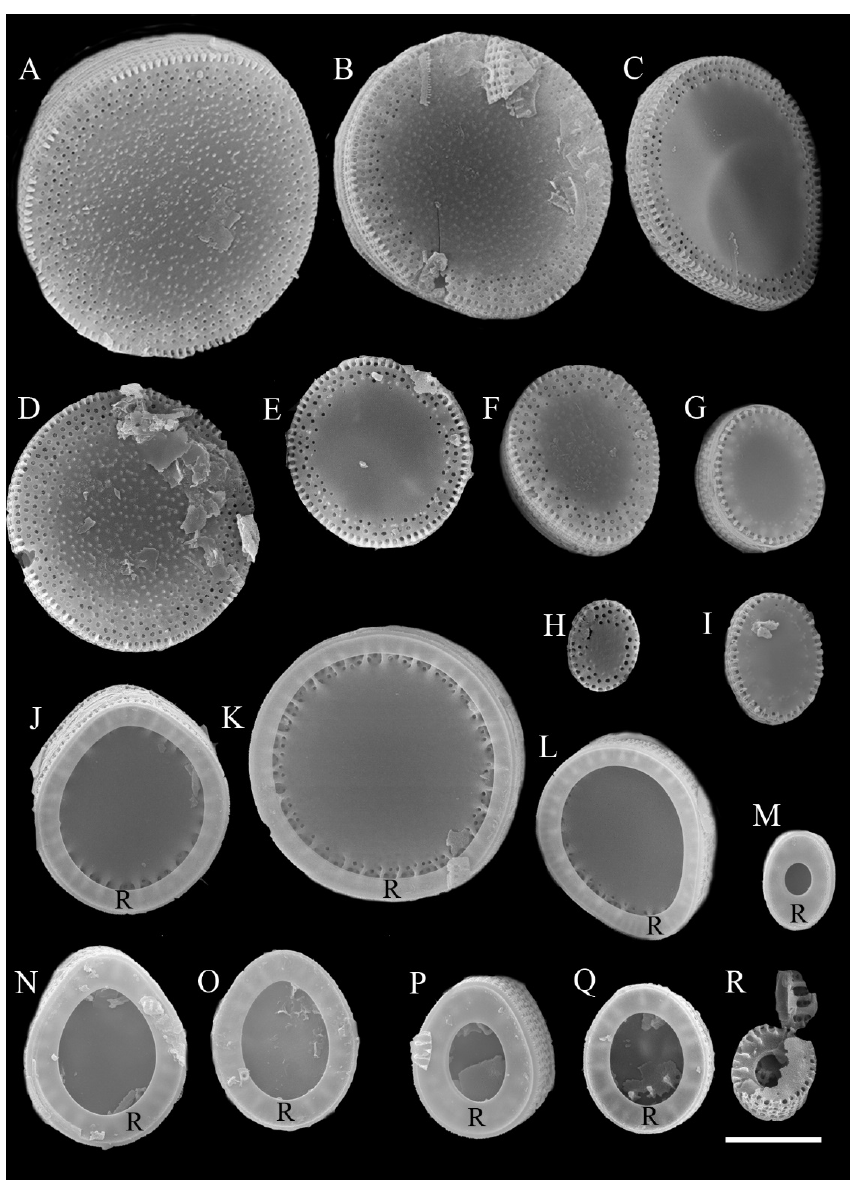
Figure 7. Alveolophora antiqua in the depth interval of 61–55 m from core 517 of the Barguzin Valley: ( A – I )—external views, valve face; ( J – R )—internal views showing a ringleist (R), variability of valves and aperture of ringleist in their shape. SEM. Scale bar: 10 µm.